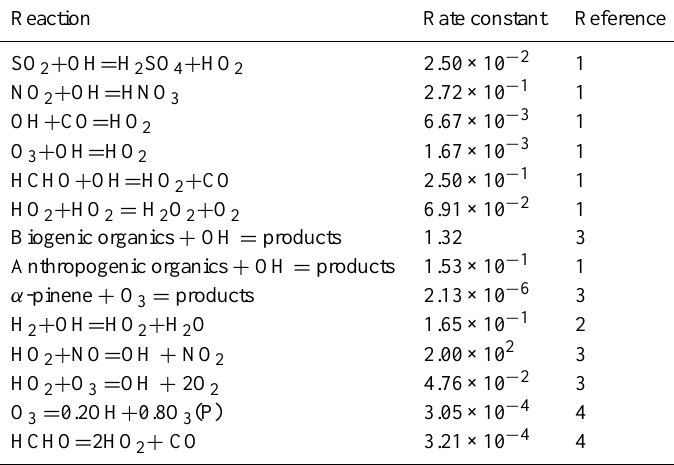
Table 2. Chemical reactions implemented within the UHMA model (Reference 1 = (Hertel et al., 1993), 2 = (Boy et al., 2006), 3 = (Seinfeld and Pandis, 2006), 4 = , Simpson et al., 1997). Second order rate constants are expressed in [ppb − 1 s − 1 ] for a temperature of 298K. Photolysis rate constants are expressed in s − 1 and computed as J = l × ( cos 2) m × e − n × sec 2 , wherein 2 is the solar zenith angle. Typical peak values of photolysis rate constants for the MMSF site during a clear sky day in May are reported.